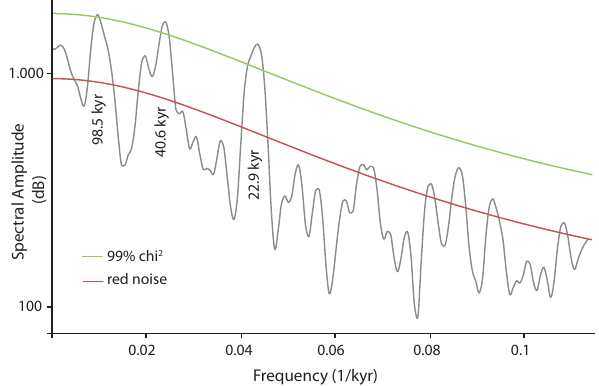
Fig. 5. Bias-corrected spectrum of sample scores of PC1 using the software REDFIT38, applying the Lomb–Scargle periodogram for unevenly spaced time series in combination with the Welch’s over- lapped segment averaging procedure (Mudelsee et al., 2009). Num- ber of segments n 50 =14; window type: boxcar; red line: red noise level; green line: 99% false-alarm level ( χ 2 ). Significant cycles at 98.5, 40.6 and 22.9kyr exceed both the red noise and the con- fidence